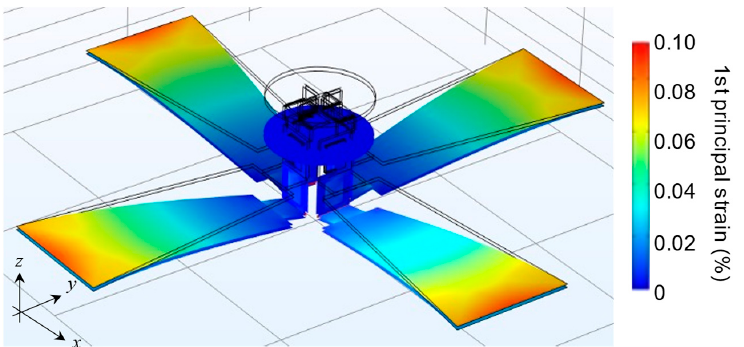
Figure 4. Result of the shock analysis: deformation shapes and strain contour plots when the maximum first principal strain was observed for an acceleration of 3000 G along the z -axis applied